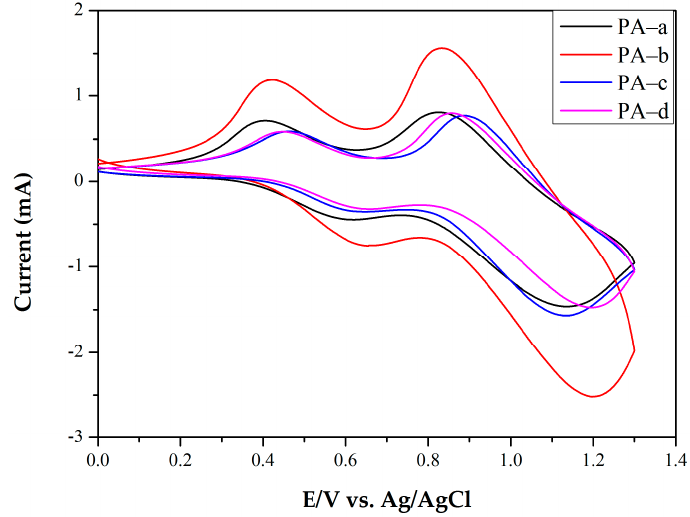
Figure 3. CV diagrams of PAs coated on ITO-coated glass slides in 0.1 M Bu 4 NClO 4 /ACN solution at a scan rate of 50 mV s − 1 . Table 3. Electrochemical properties of PAs.